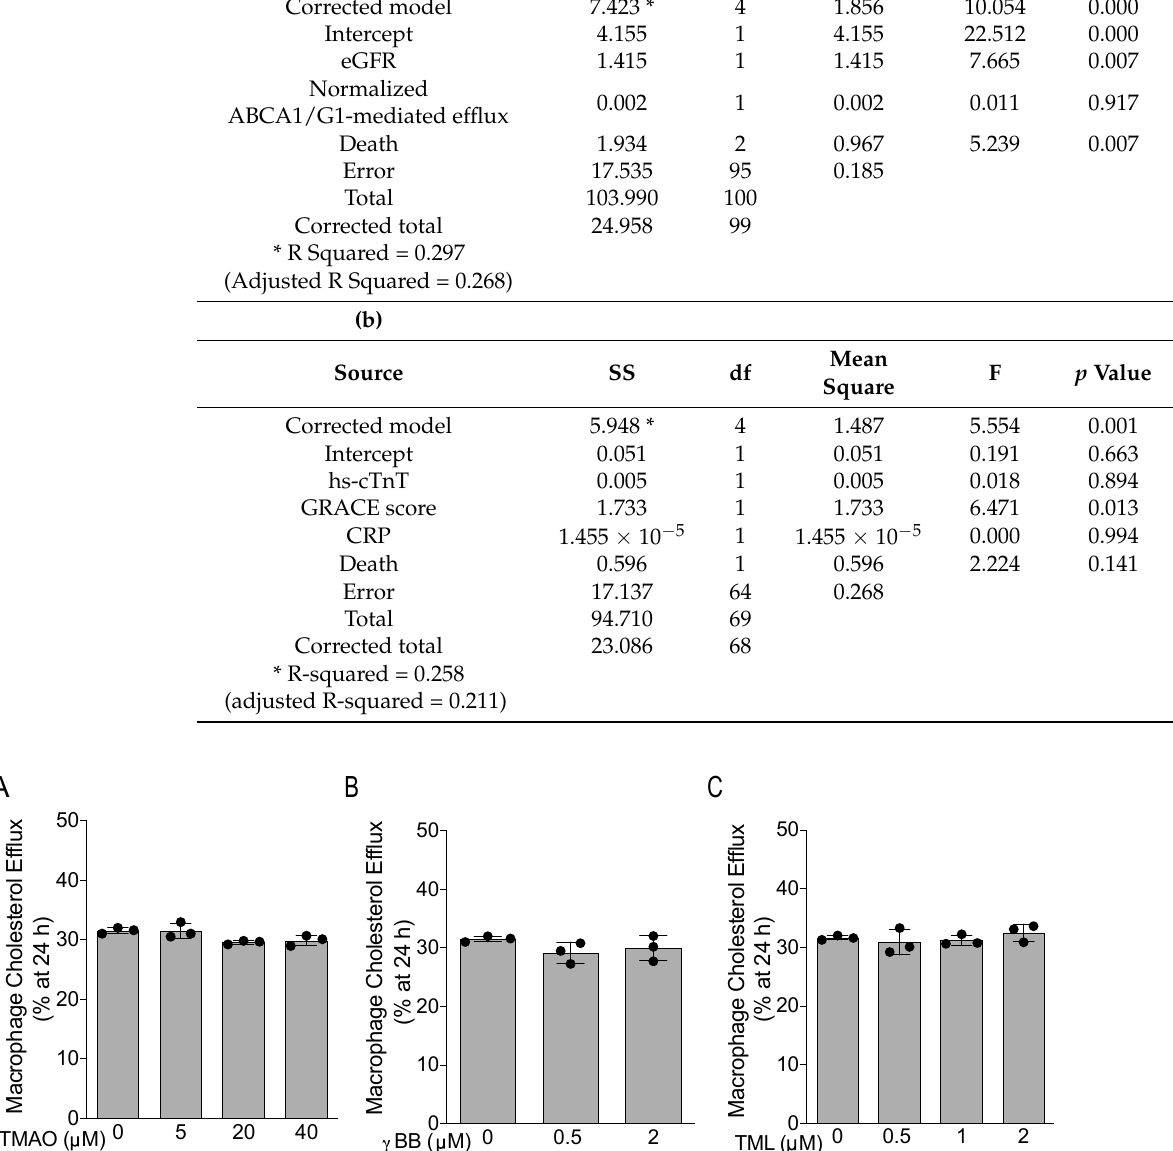
Figure 3. Effects of TMAO, γ BB, and TML on ABCA1/G1-mediated macrophage cholesterol efflux to APOB-depleted plasma. The macrophage cholesterol efflux capacity was expressed as % of fluorescence released at 24 h. TMAO ( A ), γ BB ( B ), and TML ( C ) levels did not affect the macrophage cholesterol efflux to the APOB-depleted plasma under the conditions stimulating the ABCA1/G1-dependent pathways. Kruskal-Wallis and Dunn’s post-test did not reveal significant differences among the groups incubated with the gut microbial-derived metabolites versus the control group without TMAO, γ BB, and TML . Three independent experiments were performed for each condition.